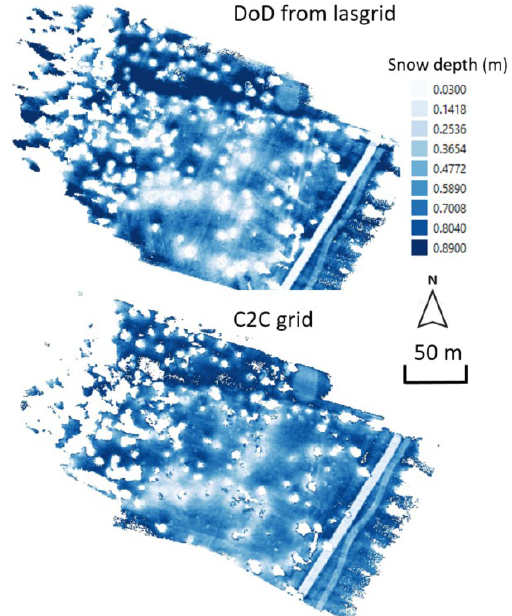
Figure 3 . Snow depth grids extracted from DoD lasgrid and C2C